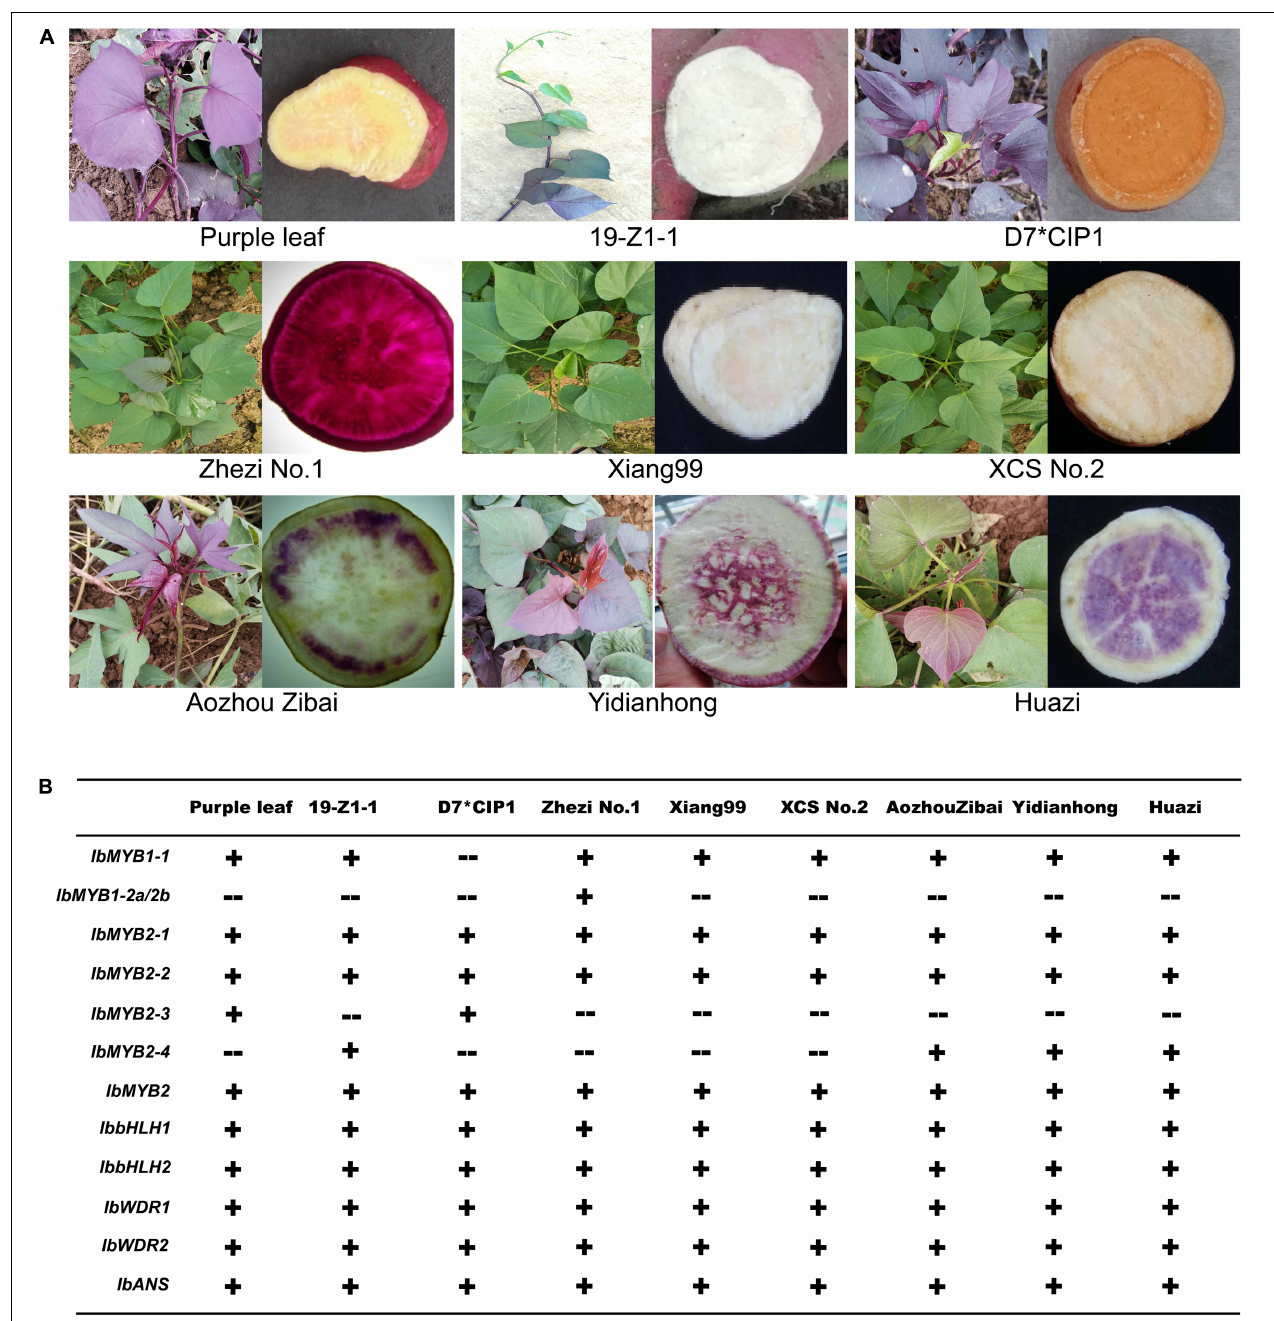
FIGURE 1 | Anthocyanin accumulation polymorphisms and genotype polymorphisms in nine sweet potato cultivars. (A) Anthocyanin accumulation polymorphisms of nine sweet potato cultivars. (B) Genotype polymorphisms related to anthocyanin biosynthesis in nine sweet potato cultivars.